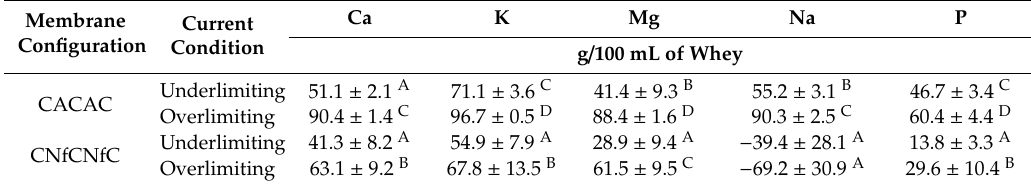
Table 4. Ion migration rates (g / 100 mL of whey) from whey compartment at the end of ED for all configurations and current conditions